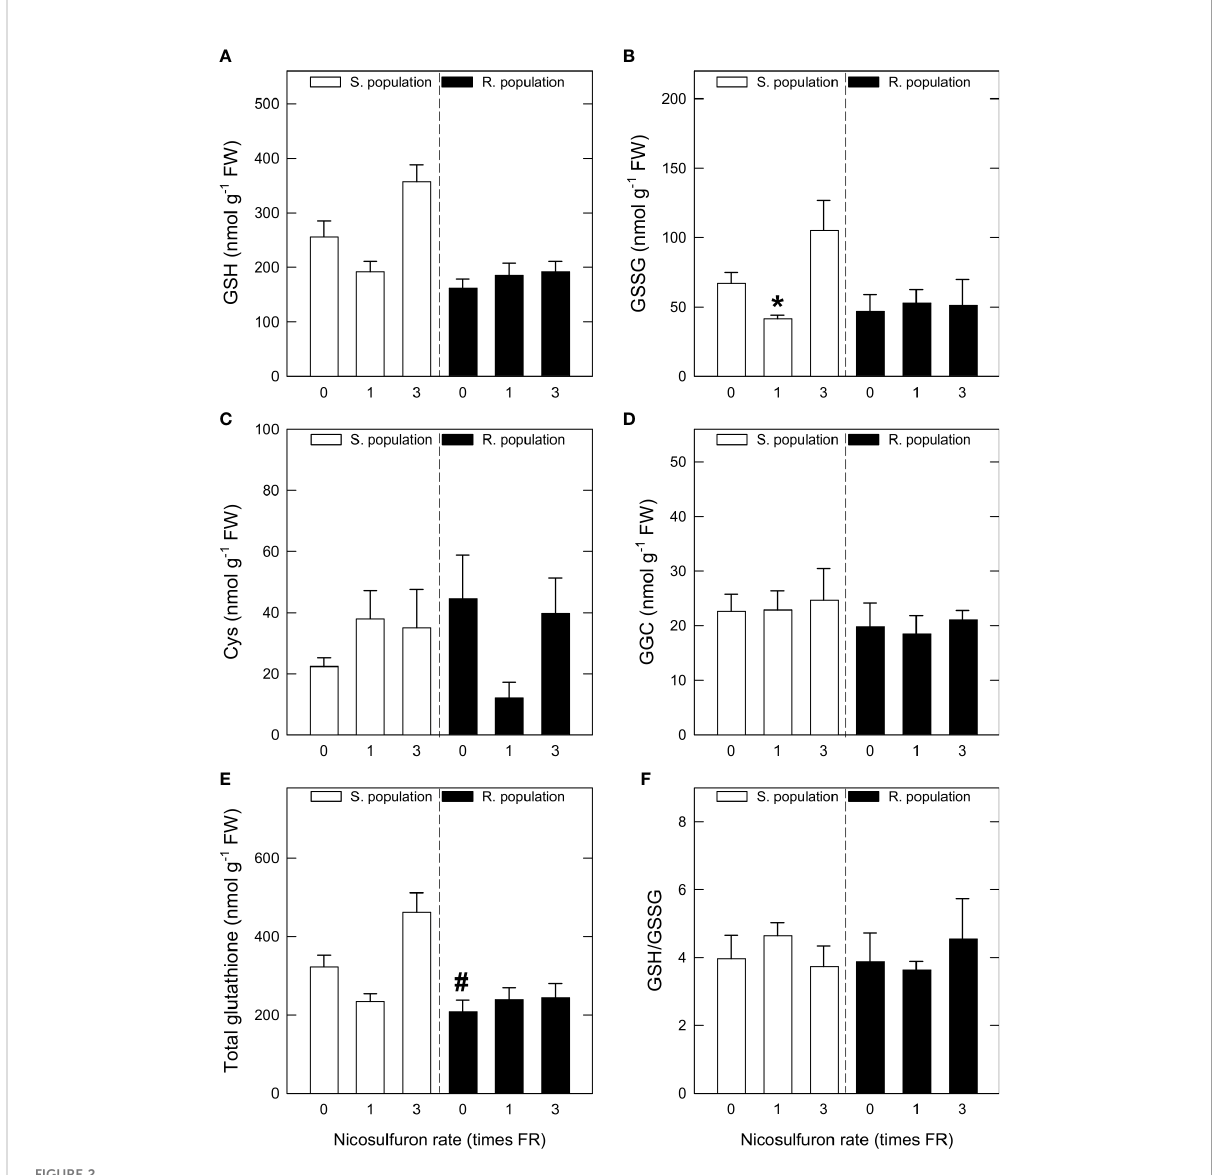
FIGURE 2 Reduced glutathione (GSH) content (A) , oxidised glutathione (GSSG) content (B) , g -glutamyl-cysteine (GGC) content (C) , Cys content (D) , sum of GSH and GSSG (total glutathione) contents (E) and GSH to GSSG ratio (F) in Amaranthus palmeri sensitive (S, white) and resistant (R, black) populations treated with different nicosulfuron rates (X axis, times recommended fi eld rate or FR, FR = 0.06 kg ha -1 ). Mean ± SE (n = 4). Signi fi cant differences between untreated S and R plants are highlighted with pound symbols (Student ’ s t-test, p value ≤ 0.05). For each population, signi fi cant differences between treatments and their respective untreated are highlighted with asterisks; (Student ’ s t-test, p value ≤ 0.05). "#" indicates